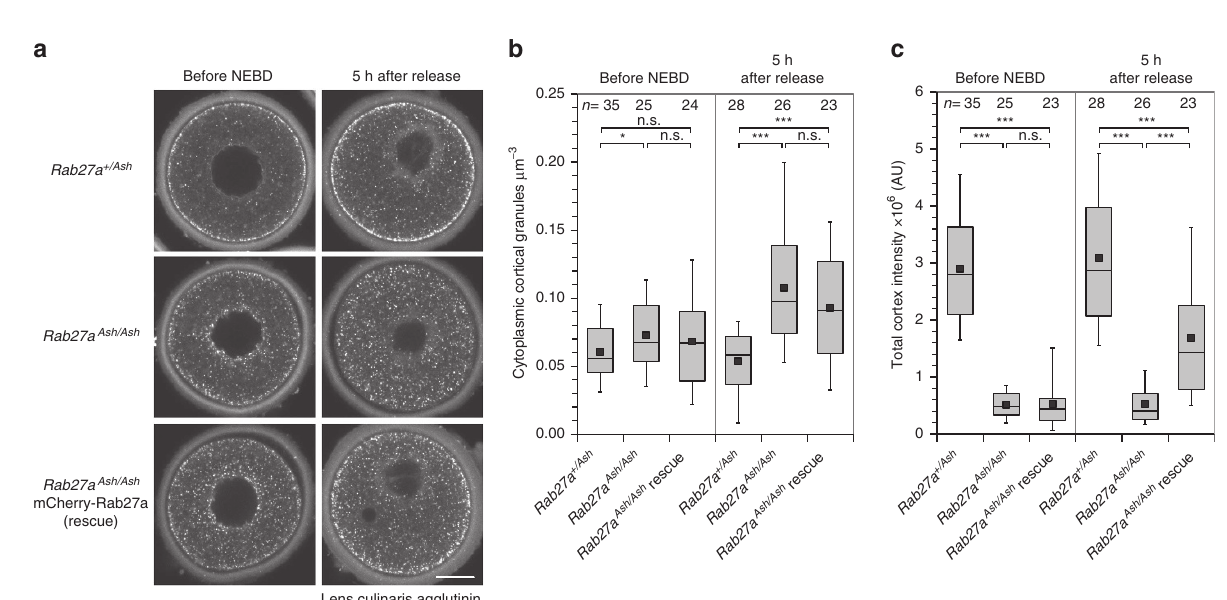
Figure 2 | Rab27a is required for cortical granule translocation. ( a ) Maximum intensity projections of confocal micrographs of Rab27a þ /Ash (control) or Rab27a Ash/Ash (mutant) oocytes at NEBD or released for 5h, then fixed and stained with lens culinaris agglutinin. Scale bar, 20 m m. ( b ) Quantification of cortical granules in the cell centre for the conditions in a . ( c ) Quantification of cortical granules at the cell cortex for the conditions in a. Tukey box plots in b , c show the median (line), mean (small square), interquartile range, and the 5th and 95th (whiskers). Significance levels: ns non-significant, * P o 0.05, *** P o 0.001, analysed using Kruskal–Wallis’ ANOVA test from three